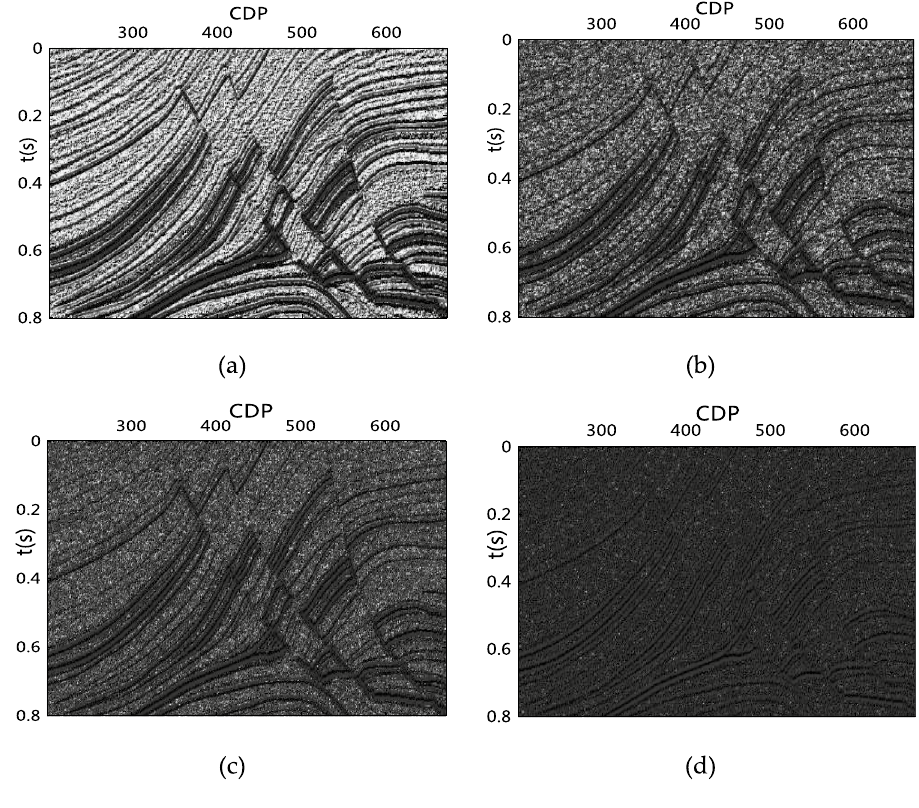
Table 1 Quantitative evaluation of different